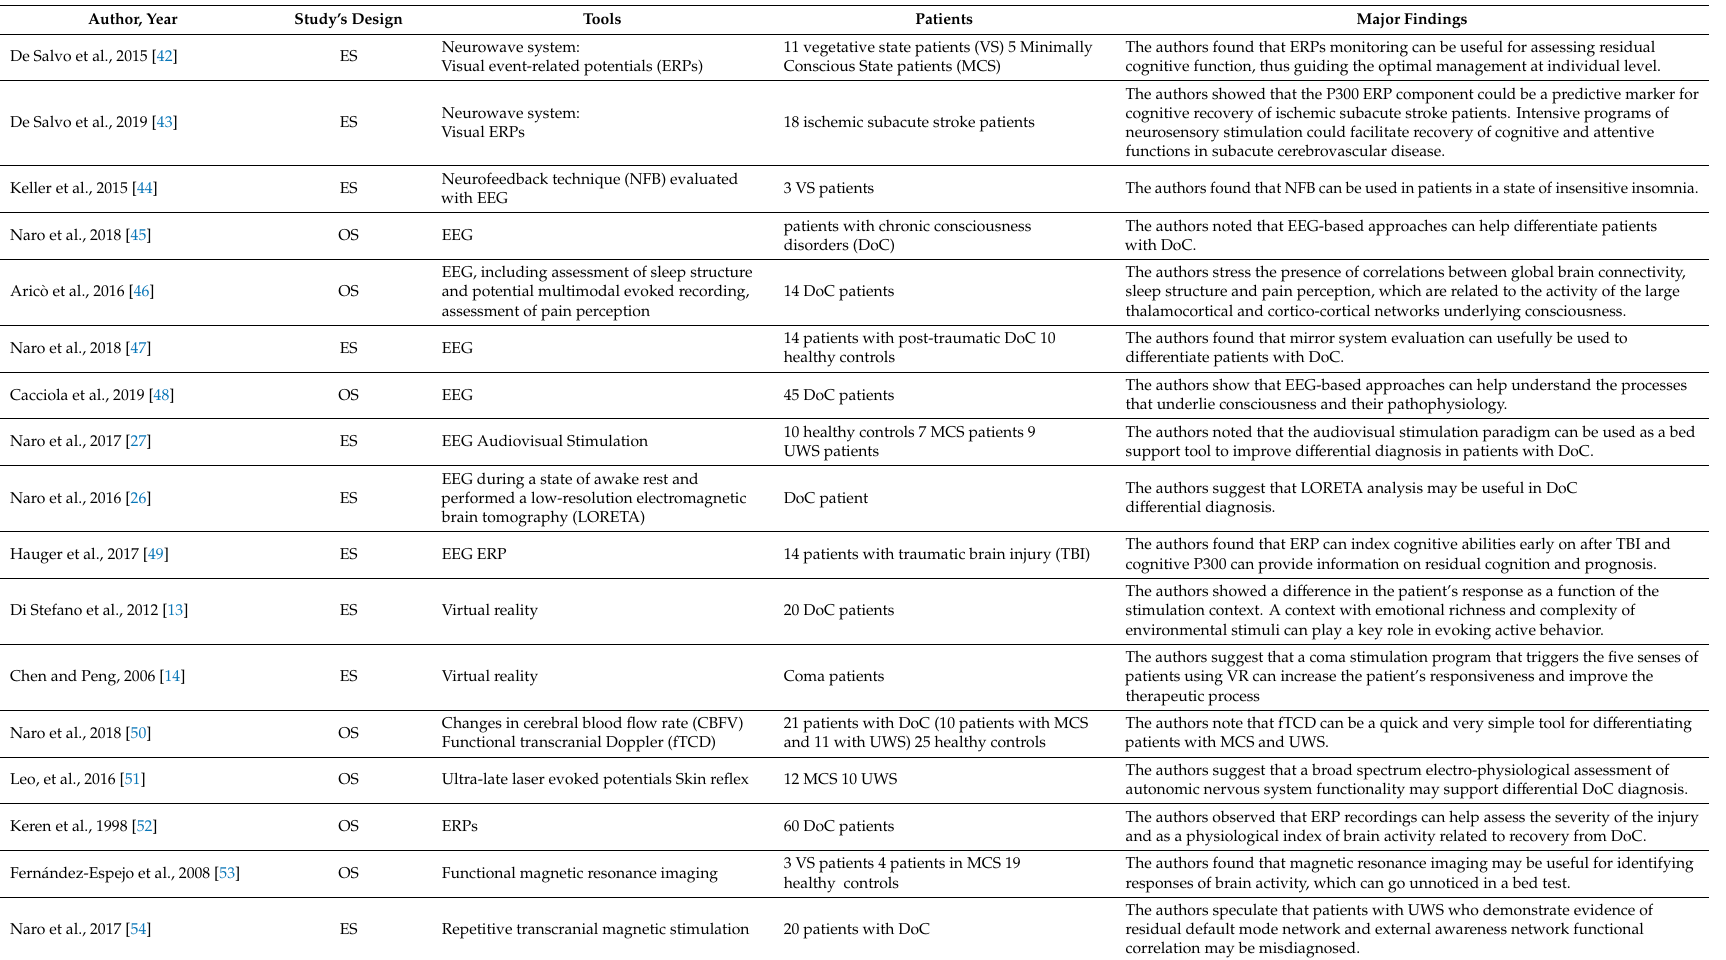
Table 1. The studies included in the systematic review. ES, experimental study; OS, observational